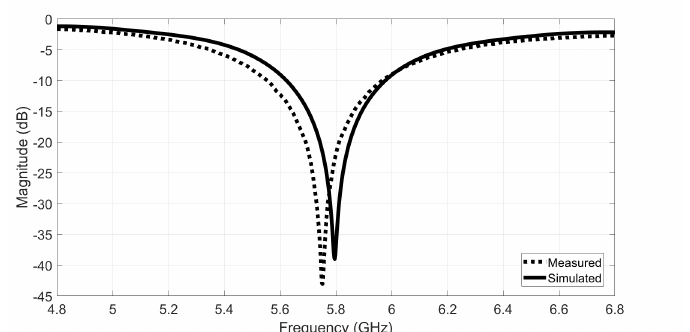
Figure 9. Simulated and measured S 11 control antenna design for the new ε r